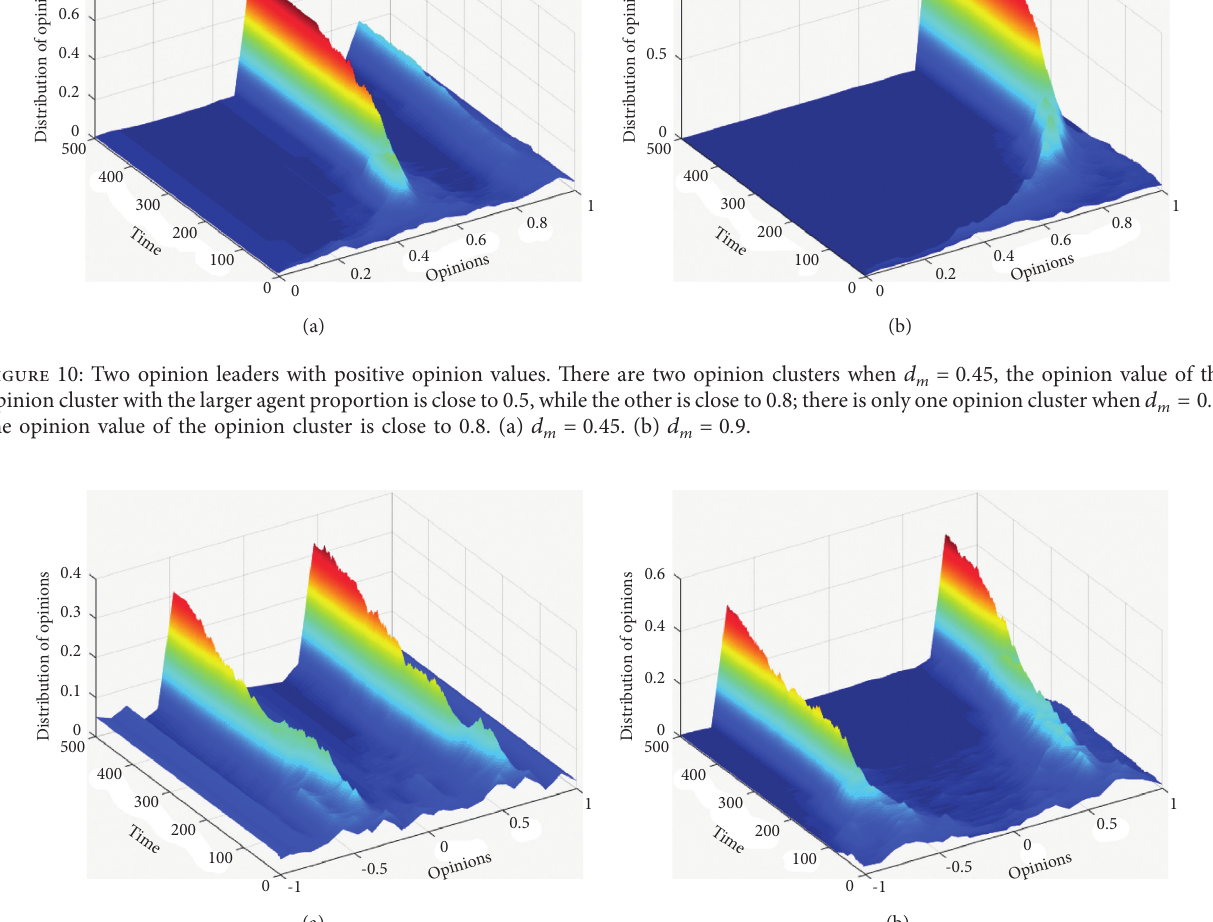
� 0 . 45; the opinion values of these m